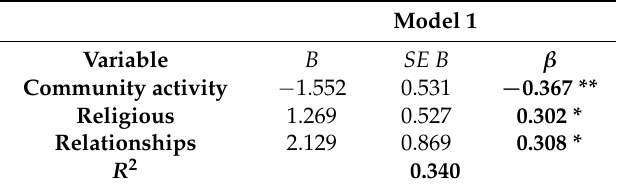
Table 3. Summary of regression analysis for variables predicting successful